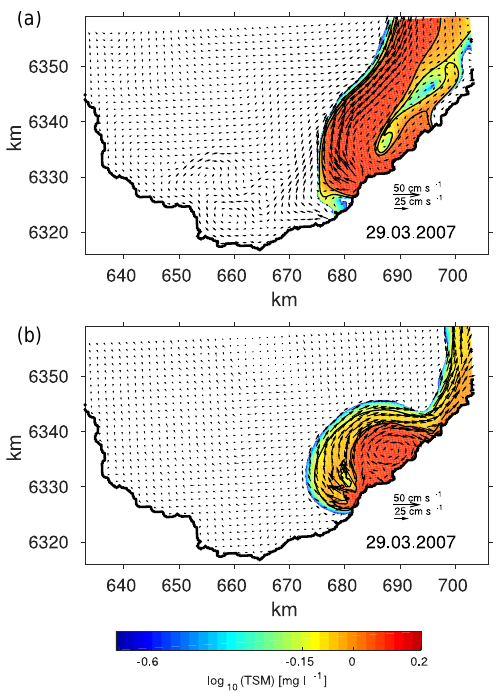
Figure 5. Instantaneous surface velocity and TSM concentration maps for simulation with realistic ambient density and no wind forcing (a) and idealized model simulation with uniform ambient density and no wind forcing (b) at noon on 29 March 2007. Solid lines represent TSM concentrations of log 10 (TSM) = − 0 . 15 and = − 0 . 05. The coordinate system is on the UTM-34v projection.